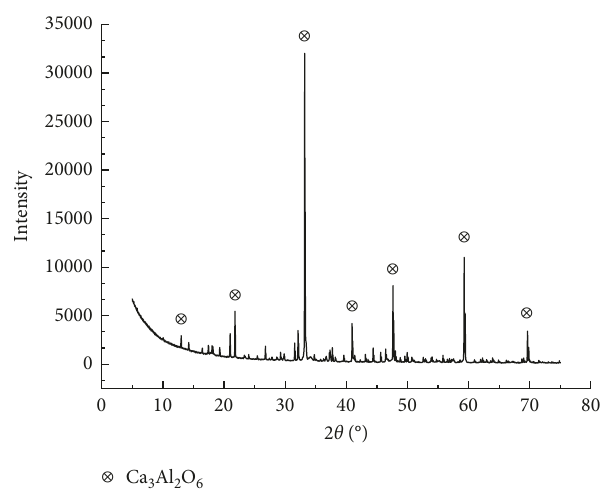
Figure 2: XRD patterns of C